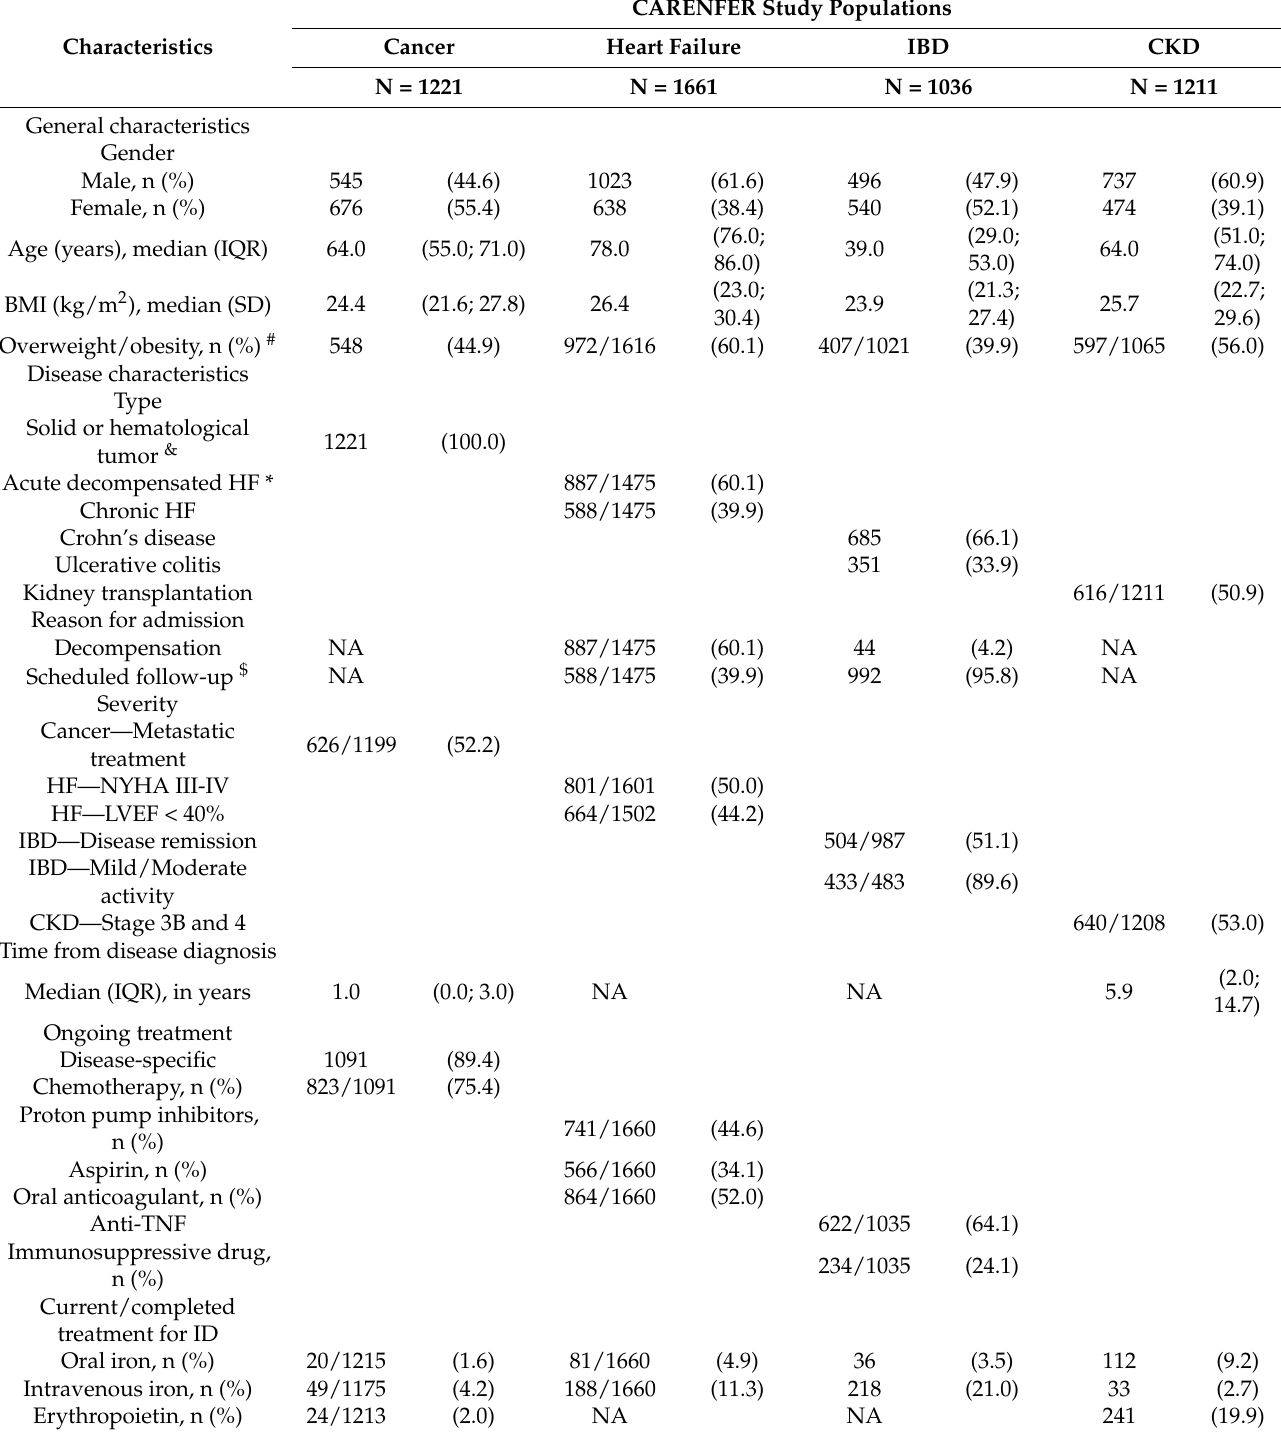
Table 2. General and clinical characteristics of CARENFER study